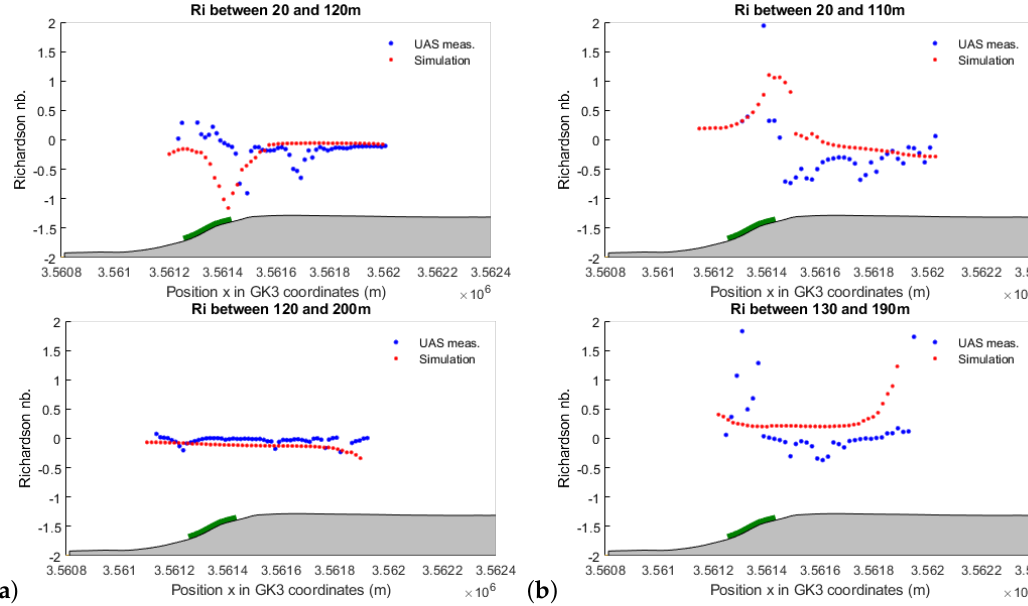
Figure 15. Bulk Richardson number computed from the UAS measurements on 21 ( a ) and 22 ( b ) September at different altitudes along the UAS’s flight path using 20 m horizontal intervals. The green block represents the modelled